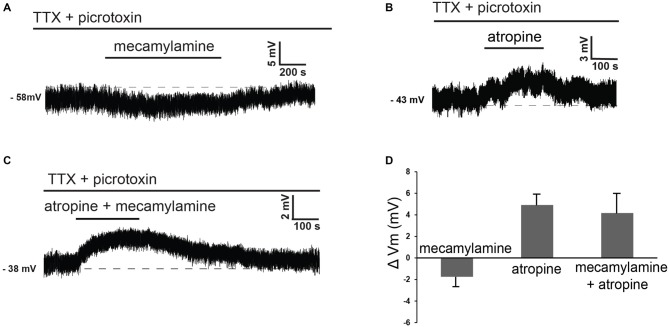
Nicotinic and muscarinic antagonists affect LTS interneurons in the presence of TTX and picrotoxin. (A) In the presence of TTX and picrotoxin, mecamylamine reversibly hyperpolarized a LTS interneuron. (B) In the presence of TTX and picrotoxin, atropine reversibly depolarized a LTS interneuron (different cell from panel A). (C) In the presence of TTX and picrotoxin, co-application of mecamylamine and atropine caused a reversible depolarization in a LTS interneuron (different cell from panels A,B). (D) Average effects of mecamylamine alone (n = 4), atropine alone (n = 4) or co-application of mecamylamine and atropine (n = 4) on the membrane potential of LTS interneurons. Twelve different interneurons were used for these applications.